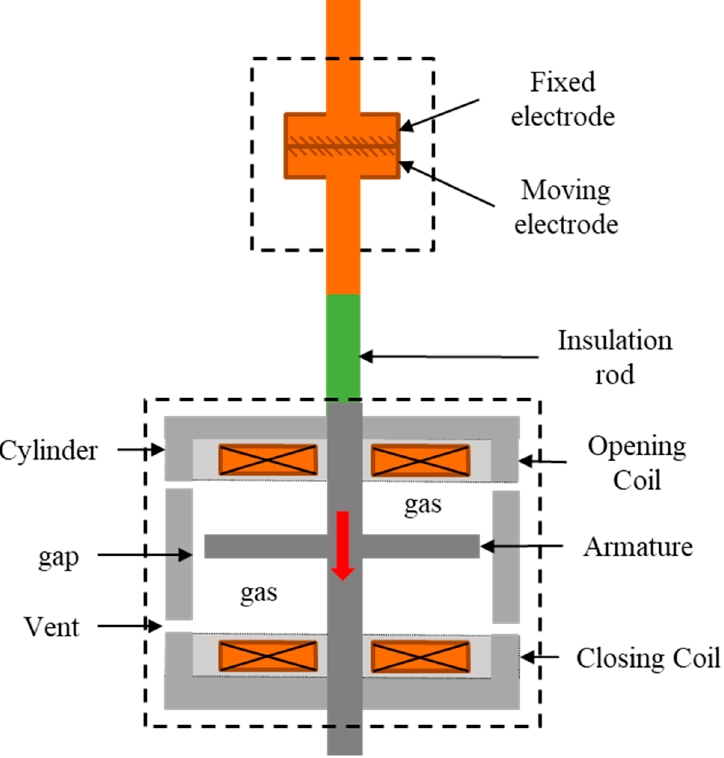
Figure 10. TCA utilizing a gas pressure buffer , redrawn as depicted in